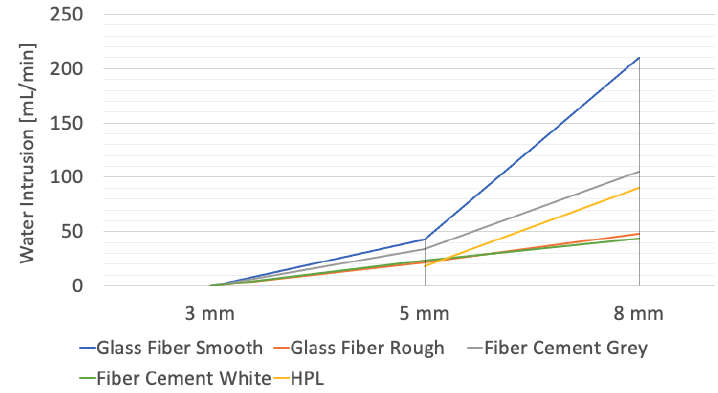
Figure 8. Water intrusion to the wind barrier for five different panels with 3, 5, and 8 mm joint widths. The water intrusion to the interior side of the panels varies greatly, as shown in Figure 9. The same trend is evident for all the panels, except for Glass Fiber Rough, with an increase in water intrusion when joint widths are increased from 3 mm to 5 mm and a smaller decrease from 5 mm to 8 mm. Note that there is no measurement combining the HPL panels with a 3 mm joint width because the recommended joint width for these panels is ≥ 8 mm, larger than the others, as shown in Table 3.